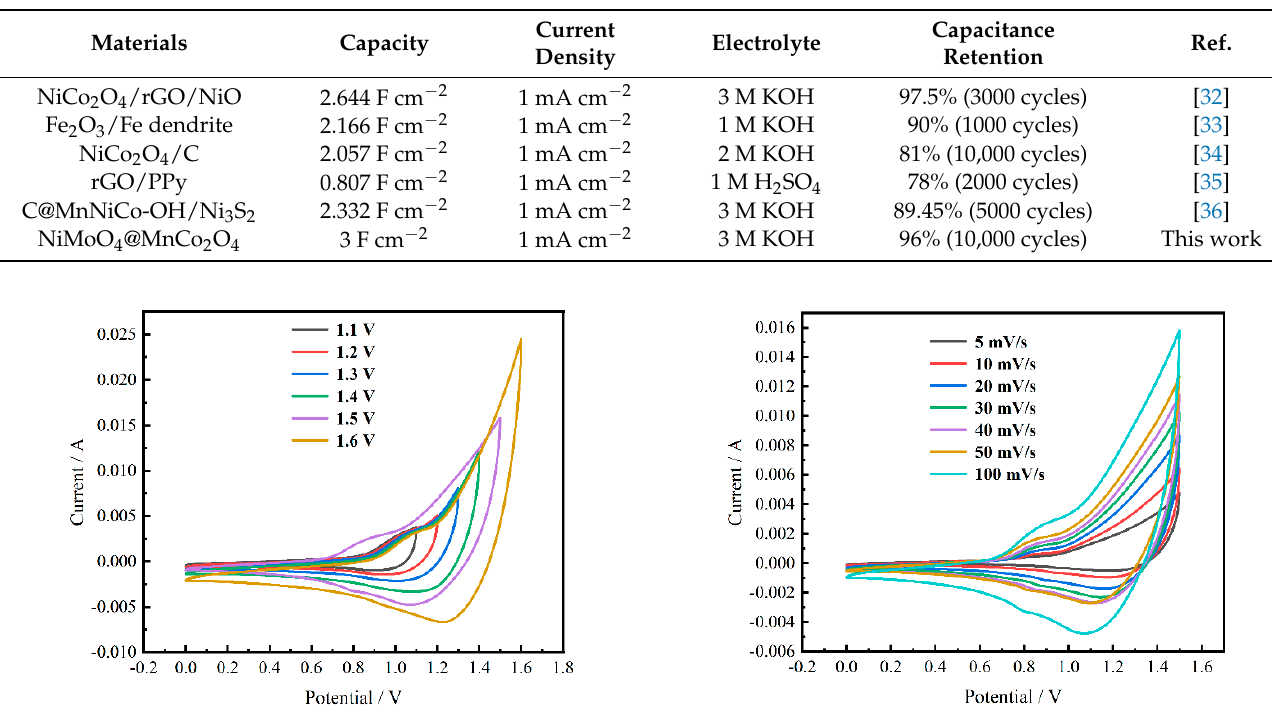
Table 1. Electrochemical performance comparison of NiMoO 4 @MnCo 2 O 4 with previous literatures.